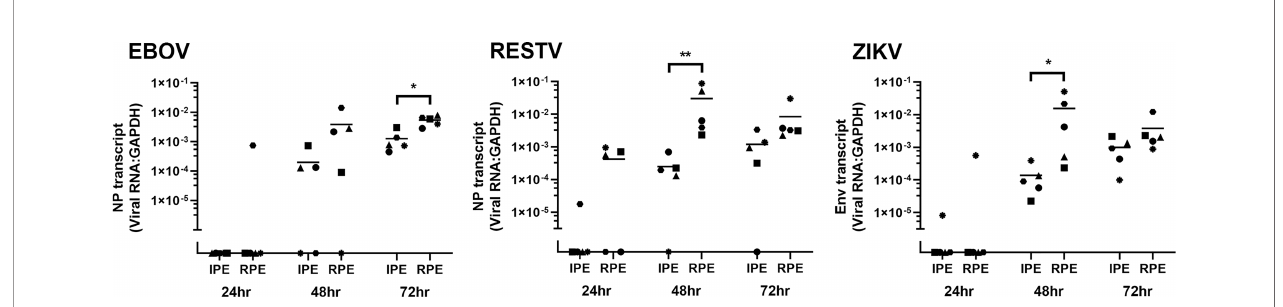
FIGURE 2 | Graphs showing viral transcript in EBOV-, RESTV- and ZIKV-infected human iris (IPE) and retinal (RPE) pigment epithelial cell monolayers 24, 48 and 72 hours (hr) following inoculation at a multiplicity of infection of 1 (n = 5 donors/condition). NP = ebolavirus nucleoprotein; Env = ZIKV envelope. Shapes represent individual cell isolates, and crossbars represent means. Statistical comparisons were made between IPE and RPE by Mann-Whitney U test (* p < 0.05; ** p <